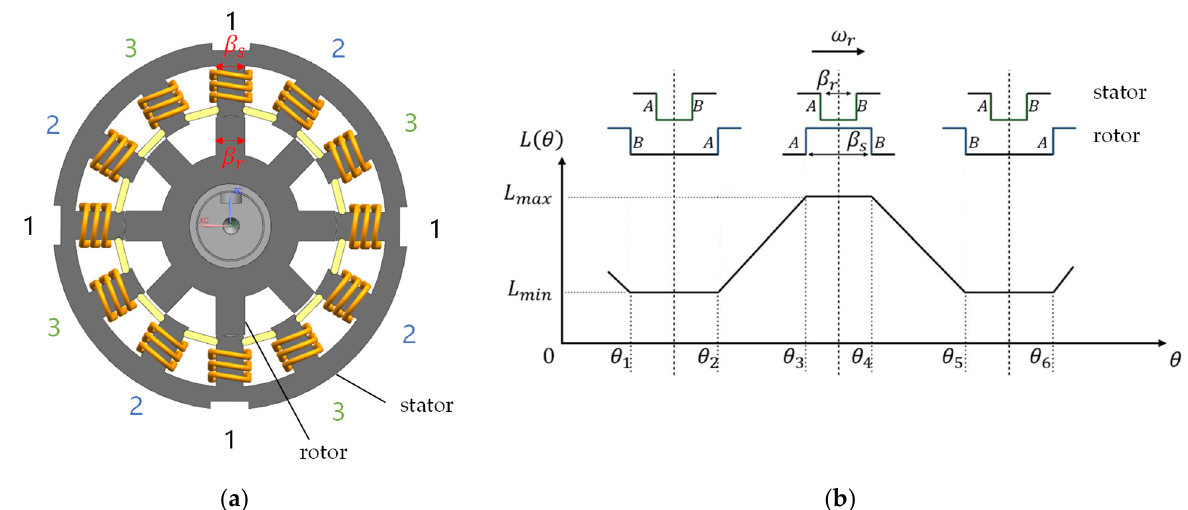
Figure 1. ( a ) The simplified structure of a 12-8 SRM ( b ) Inductance curve of linear model. Figure 1b also shows the variation curve of the inductance with respect to the rotor angle position θ under the linear model, where θ 1 to θ 5 is an electrical cycle. When θ 1 ≤ θ < θ 2 , the stator salient pole and rotor groove overlap, and the air gap between stator and rotor is the largest, so the magnetic resistance is the largest and the inductance is the smallest. When θ 2 ≤ θ < θ 3 , the rotor salient pole begins to overlap with the stator salient pole, the air gap between the stator and rotor decreases, and the inductance increases linearly. When the stator salient pole coincides with the rotor salient pole, the inductance reaches the maximum. When θ 3 ≤ θ < θ 4 , the rotor salient pole and stator salient pole remain coincident, the air gap is the smallest, and the inductance is always the maximum. When θ 4 ≤ θ < θ 5 , the rotor salient pole gradually separates from the stator salient pole,